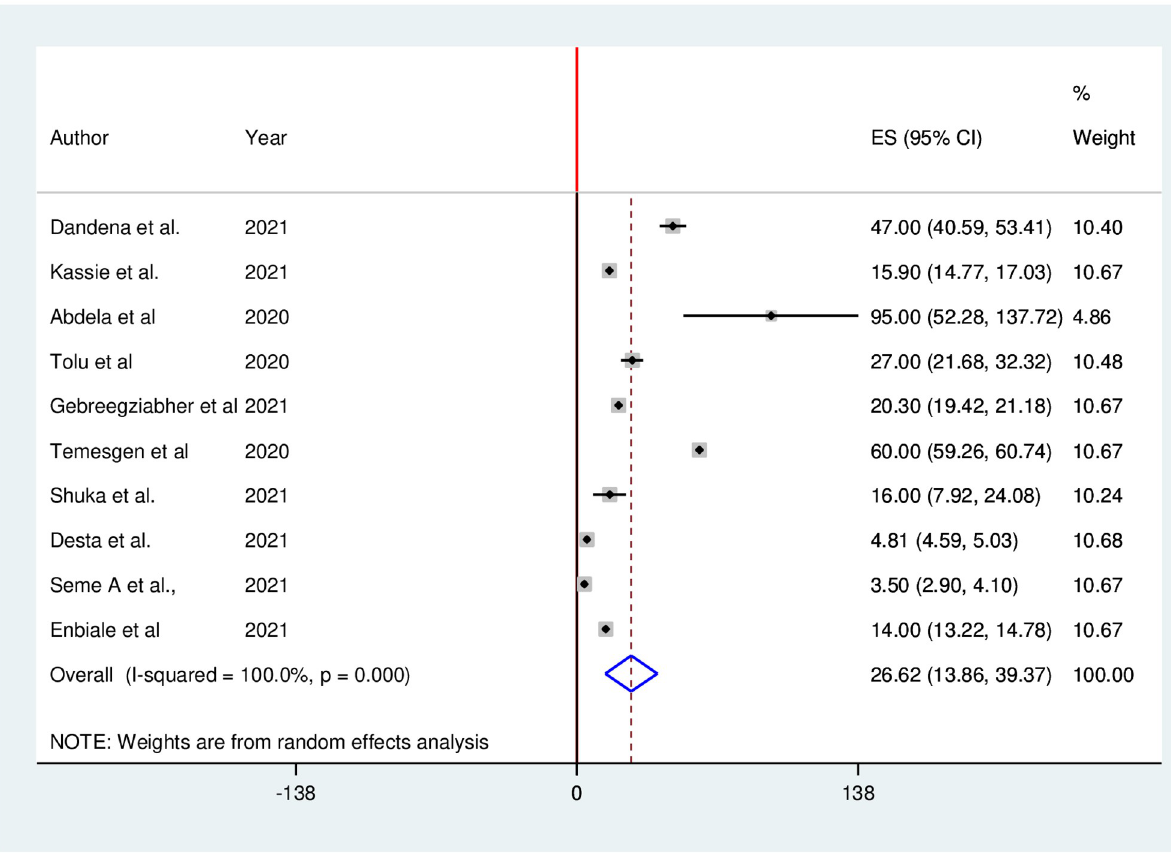
Fig 2. Forest plot of the pooled reduction of family planning services utilization during COVID-19 pandemic in Ethiopia, 2021.